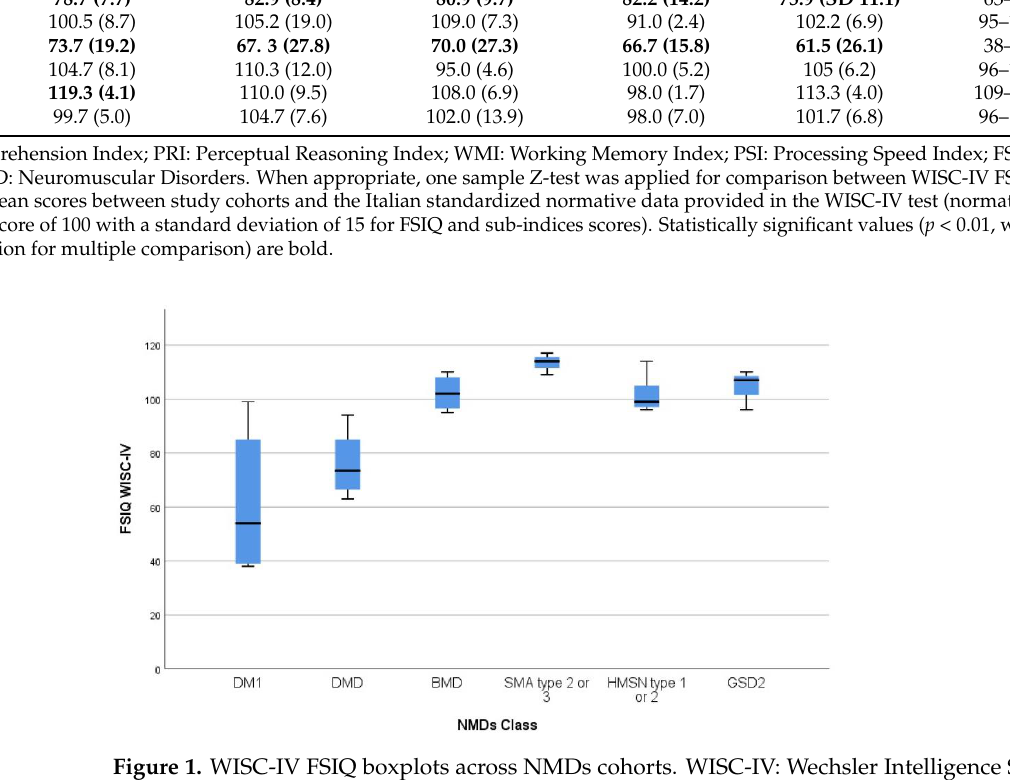
Figure 2. Correlation analysis between WISC-IV FSIQ and NSAA total scores in Duchenne muscular dystrophy (DMD) cohort. WISC-IV: Wechsler Intelligence Scale for Children, Fourth Edition; FSIQ: Full Scale IQ; NSAA: North Star Ambulatory Assessment Scale; Linear R 2 = 0.854. Since in literature there is growing evidence that intellectual functioning in DMD patients is variable depending on whether the mutations are located proximally or distally within the Dys gene, with a greater negative impact for more distal mutations, association analyses were performed to investigate a possible difference in this cohort. The cut-off, to discriminate between proximal and distal, was established by the aAuthors prior to exon 30 [39] or exon 45 [40], depending on the case. By establishing exon 30 as the cut-off, only two patients have a proximal mutation and 13 a distal mutation, thus exon 45 was consid- ered as the cut-off to run analyses. On this basis, 8 (53%) patients have a proximal muta- tion, and 7 (46%) have a distal one. Considering WISC-IV and WPPSI-III FSIQ together, in the group with a proximal mutation the FSIQ mean score was 87.0 (SD 20.9), while in the